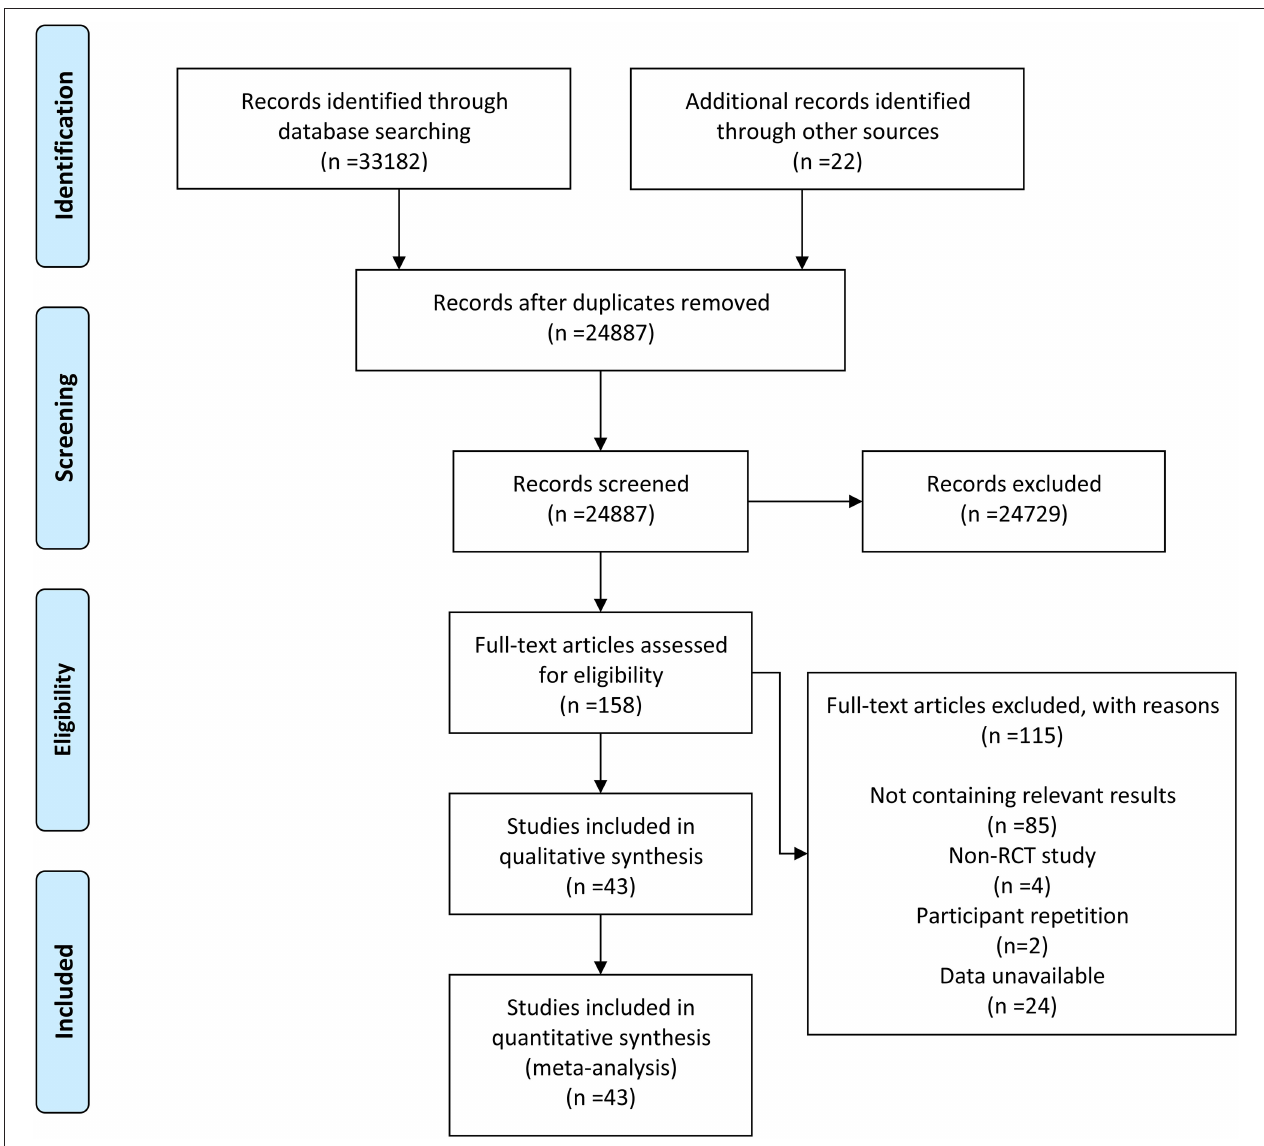
FIGURE 1 | The flowchart for the retrieval process included studies in this